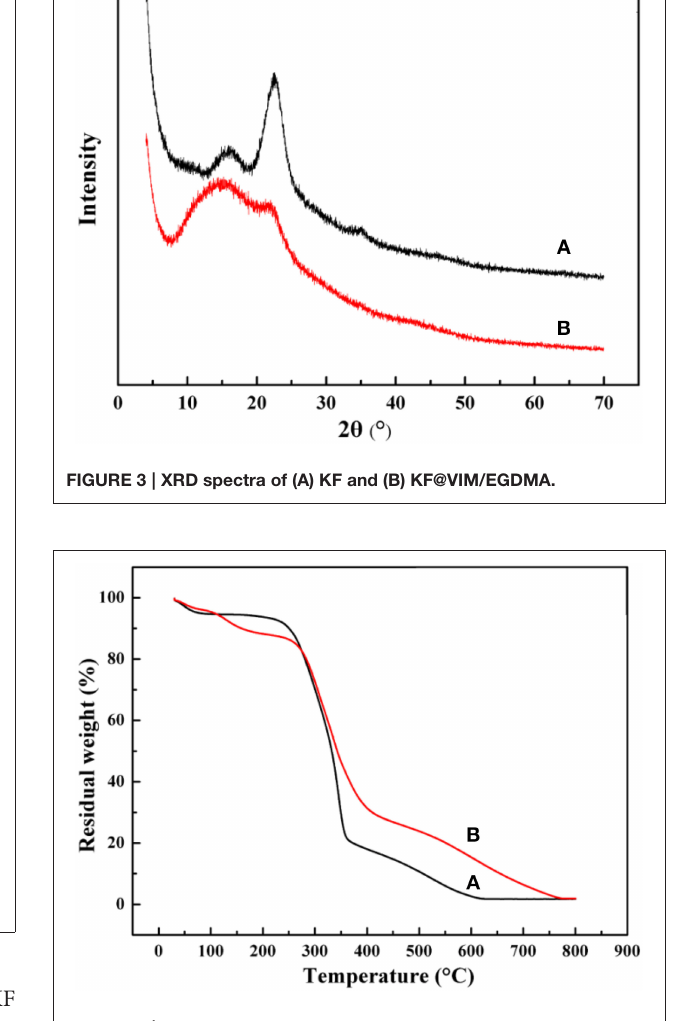
FIGURE 4 | TGA thermograms of (A) KF and (B)